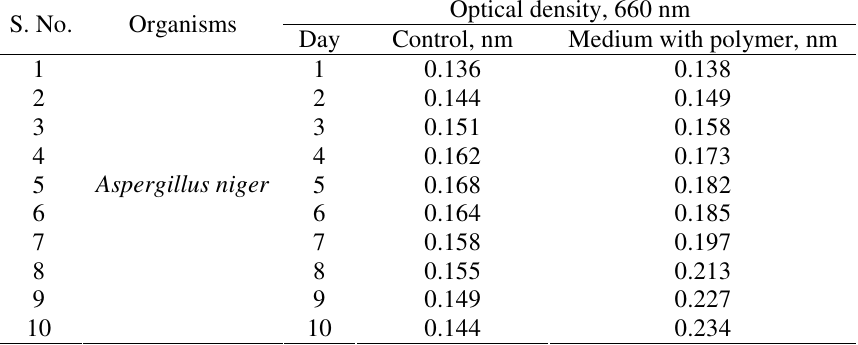
Table 5 . Degradation of polymer in liquid culture against